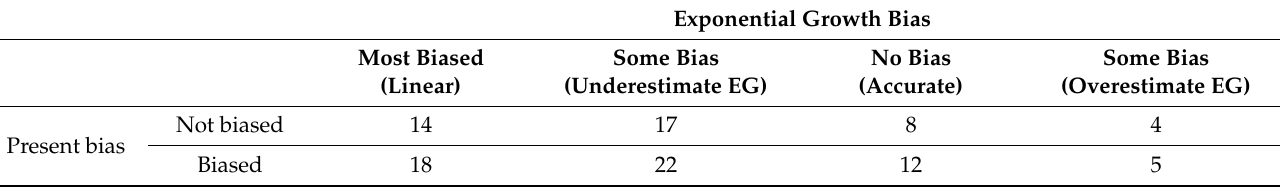
Table 1. Prevalence of exponential growth bias and present bias